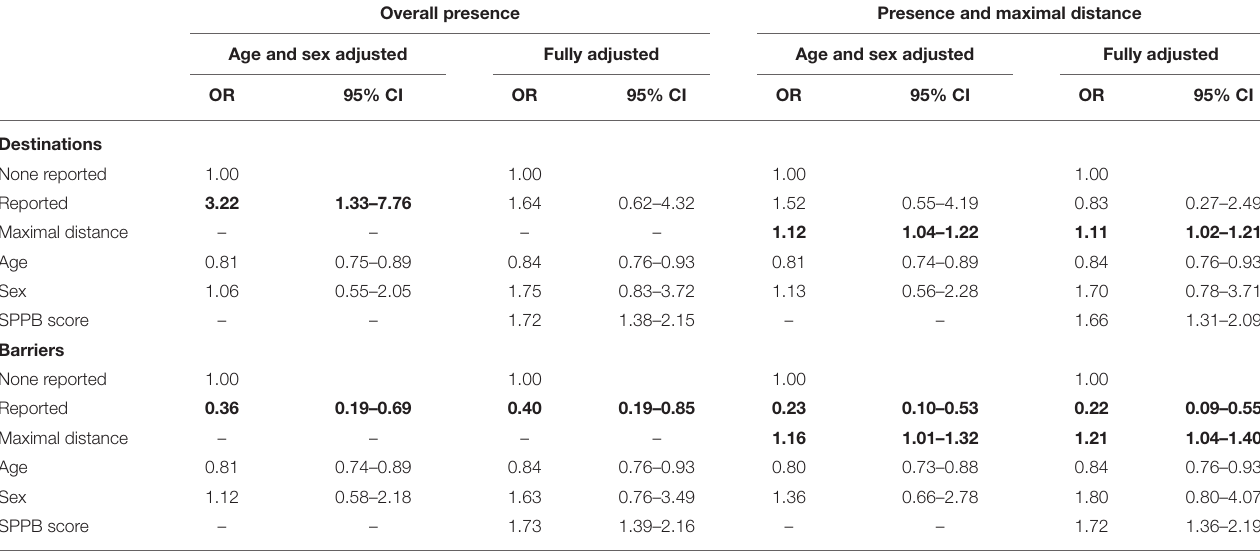
TABLE 3 | Logistic regression models of overall presence and maximal distance from home to neighborhood destinations and barriers to outdoor mobility and odds ratios (OR) for higher physical activity ( n =